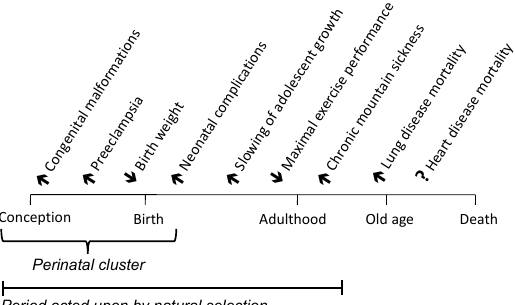
6 of 20 Table 2. Autosomal gene regions acted upon by natural selection in Andean populations. Abbreviations: AS3MT = arsenite 3 methyltransferase; BRINP3 = BMP/retinoic acid inducible neural specific 3; CLC = galectin-10; DUOX2 = dual oxidase 2; EDNRA = endothelin receptor type A; EGLN1 = egl-9 family hypoxia inducible factor 1; ELTD1 = adhesion G protein-coupled receptor L4; FAM213A = family with sequence similarity 213 member A; NOS2 = nitric oxide synthase 2; PRKAA1 = protein kinase AMP-activated, α 1 catalytic subunit; SFTPD = surfactant protein D; SP100 = SP100 nuclear antigen; TBX5 = T-box 5; TMEM38B = transmembrane protein 38B; TP53 = tumor protein p53; VEGFB = vascular endothelial growth factor B. The first genome scan to study high-altitude adaptation was performed in Andeans residing in Bolivia [76]; however to date, there have been fewer studies in Andeans than Tibetans. The peopling of the Andes appears to have begun 12,000 or more years ago [1,2,79], a timeframe that would be expected to permit the natural selection of genes that have at least a modest effect on reproductive success. Just one gene, EGLN1, has thus far been identified as being acted upon by natural selection in both Andeans and Tibetans [71]. Among Andeans, several other genes showing evidence of natural selection have been identified, including some involved in vasoregulation ( PRKAA1, NOS2 ), vascular growth ( VEGFB, ELTD1 ), cerebral blood flow ( CBS ), and oxidative defense ( FAM213A ) [71,75,77] (Table 2). There has just been one whole-genome sequencing study in Andeans to date; it identified three gene regions— BRINP3 , NOS2 , and TBX5 —with just one ( NOS2 ) having been identified previously in a SNP scan [71]. These genes have previously been associated with cardiovascular function, however not hypoxia-sensing [73]. Of note, while we commented above on the role of genetic and developmental factors for the larger lung volumes seen in Andeans, no study to the best of our knowledge has sought to determine the relationship of such morphological variation with any of the gene regions identified as having been acted upon by natural selection.